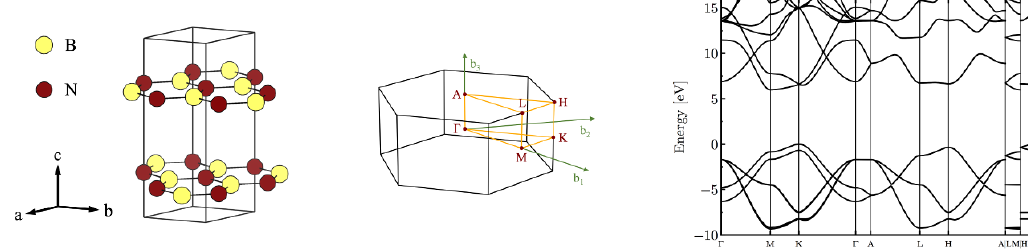
Figure 2 . Crystal structure of hexagonal boron nitride (left), its corresponding (cid:12)rst Brillouin zone (middle) and DFT-calculated electronic band structure (right) with the Fermi level set to zero. The letters shown in the Brillouin zone plot mark several of the high-symmetry points, and the orange lines mark Brillouin zone paths along which electronic band structure is plotted. The discontinuities in the band structure occur from taking a discontinuous path through the Brillouin zone, indicated by \ j " on the horizontal